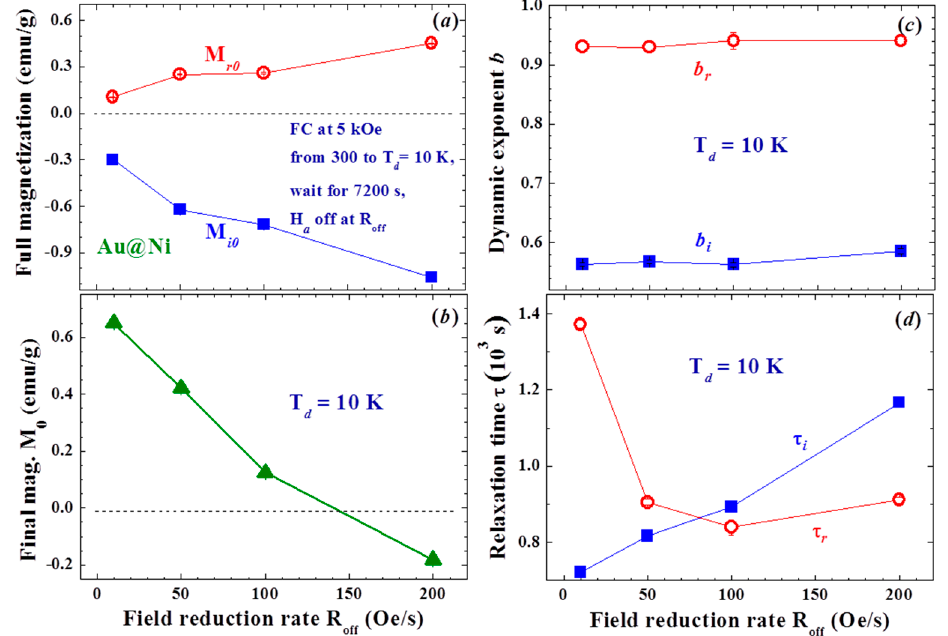
Figure 8. ( a ) variations of full residual magnetization M r0 and full induced magnetization M i0 with field reduction rate; ( b ) variations of final magnetization M 0 after long relaxation with field reduction rate; ( c ) variations of dynamic exponent of residual magnetization b r and induced magnetization b i with field reduction rate; and ( d ) variations of relaxation time of residual magnetization τ r and induced magnetization τ i with field reduction rate.